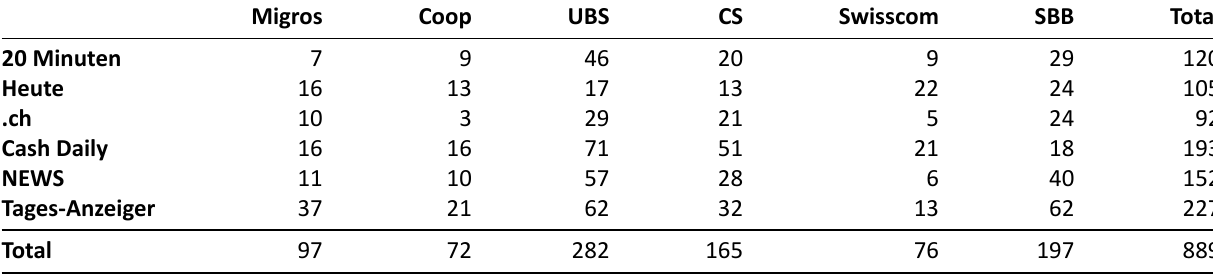
Table 2. Number of articles about the selected advertisers.